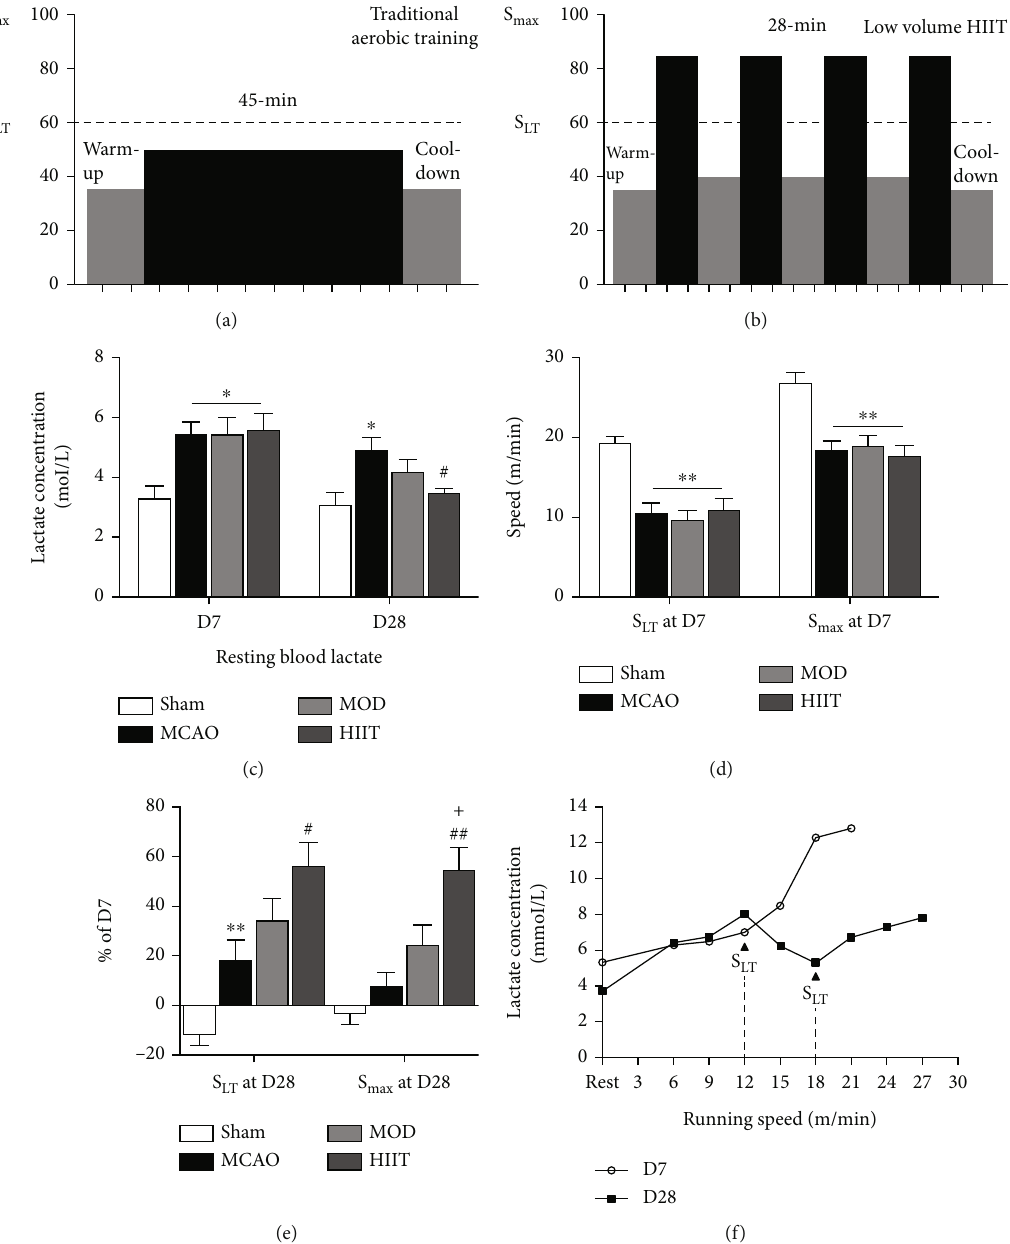
Figure 3: Exercise protocols of high-intensity interval training and moderate-intensity aerobic training. (a, b) Regimens of traditional moderate-intensity aerobic training and low volume high-intensity interval training. (c) Relative percentage (%) of resting blood lactate (mmol/L) at D28 normalized to the D1 ( n = 6 ). (d) S and S (m/min) at D7 in each group ( n = 6 ). (e) Relative percentage (%) of S LT max LT and S at D28 normalized to the D1 ( n = 6 ). (f) Example of lactatemia kinetic (raw data) before and after HIIT. Arrows indicate the max lactate threshold. Values are expressed as the mean ± SEM of the mean. ∗ P < 0 : 05 and ∗∗ P < 0 : 01 compared with the sham group; # P < 0 : 05 and ## P < 0 : 01 compared with the MCAO group as determined by one-way ANOVA (Tukey ’ s multiple comparison test) for the data with normal distribution. The letters for no signi fi cance were not shown. Abbreviation: S : speed associated with the lactate LT threshold; S : maximal speed; D7: 7 days after cerebral ischemia; D28: 28 days after cerebral max